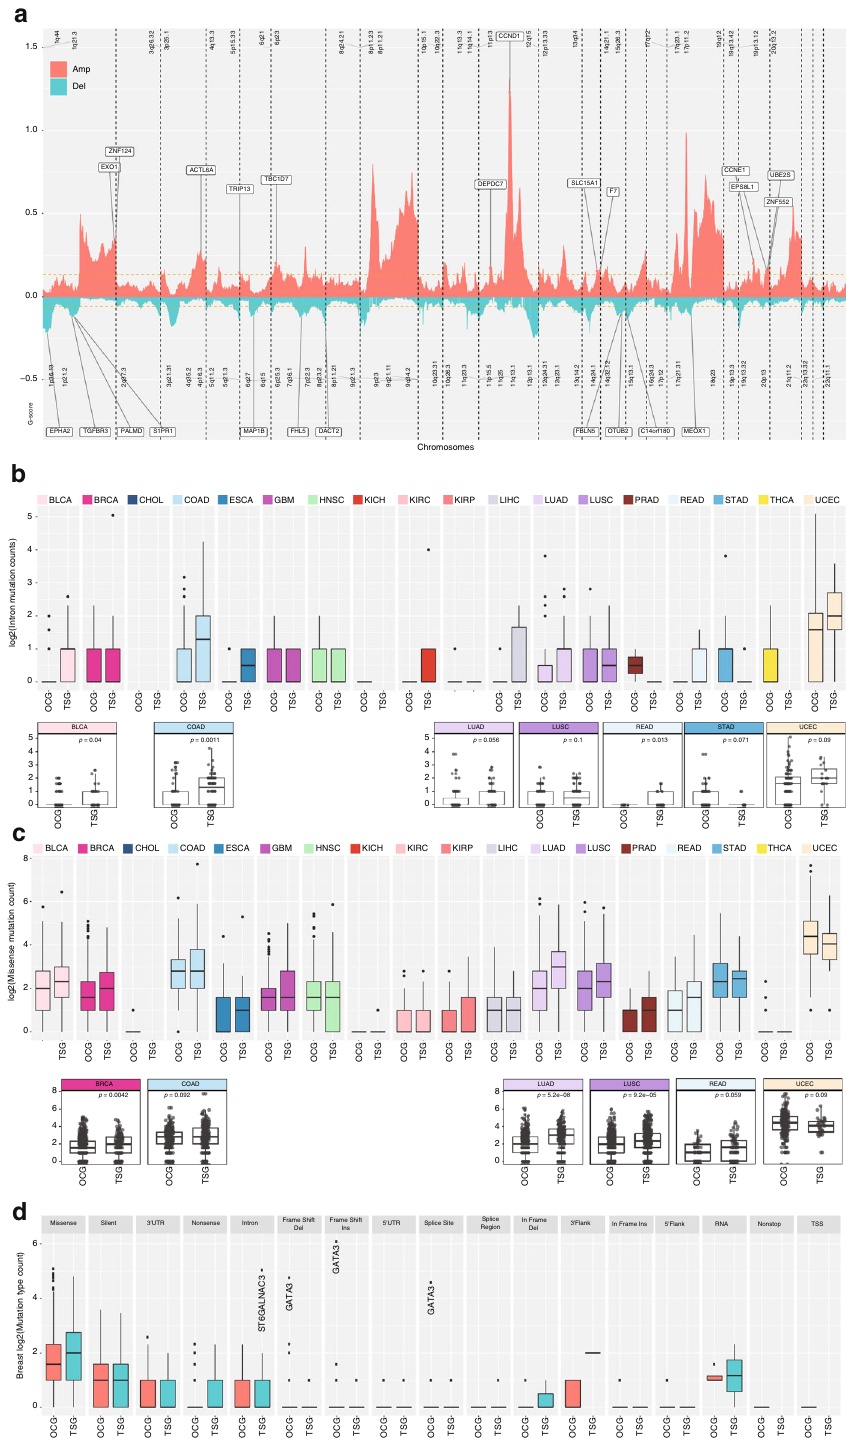
Fig. 4 Copy number and mutational landscape of oncogenic mediators. a Copy-number changes in breast cancer (ampli fi cation of oncogenes in red and deletion of tumor suppressors in blue) identi fi ed according to criteria described in the Methods section. The orange line represents the signi fi cance threshold (FDR = 0.25). The complete list of chromosome location peaks associated to cancer driver genes in Pan-Cancer study is included in Supplementary Data 8. b Boxplot showing log2 (intron mutation counts), c log2 (missense mutation counts) for tumor suppressor and oncogenes detected in Pan-Cancer study, and d breast cancer log2 (mutation type